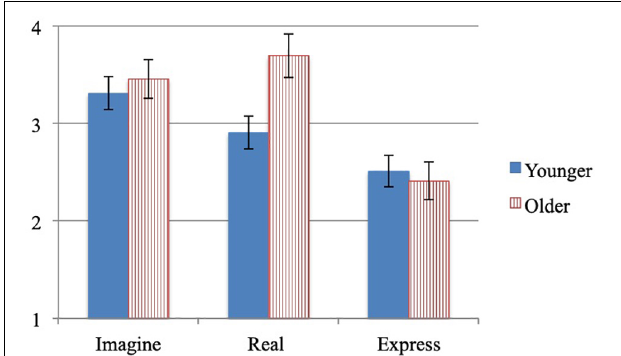
FIGURE 2 | Study 2 mean absorption by condition and age group.